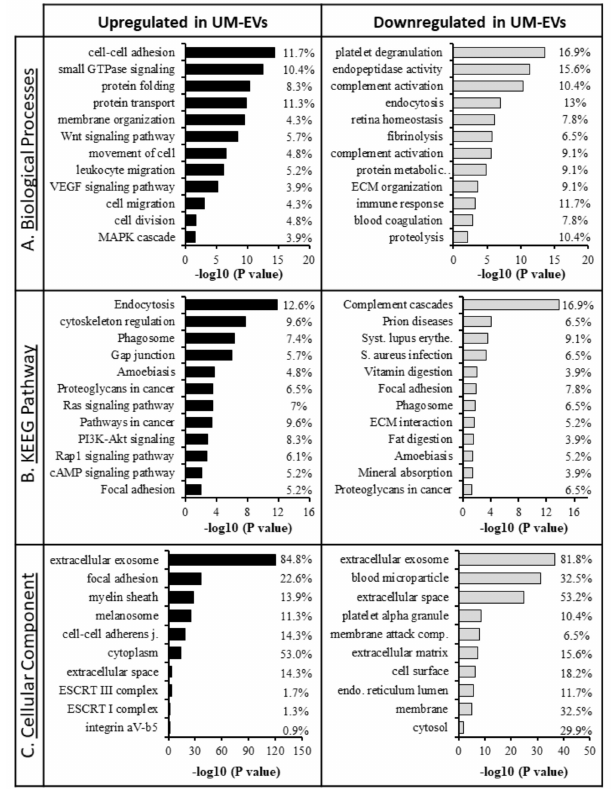
Figure 7. Gene ontology GO classification of proteomic data for di ff erentially expressed proteins in primary UM-EVs and NCM-EVs. The most enriched categories in ( A ) biological process, ( B ) molecular function, and ( C ) cellular component. Left panel—UM-EVs, right